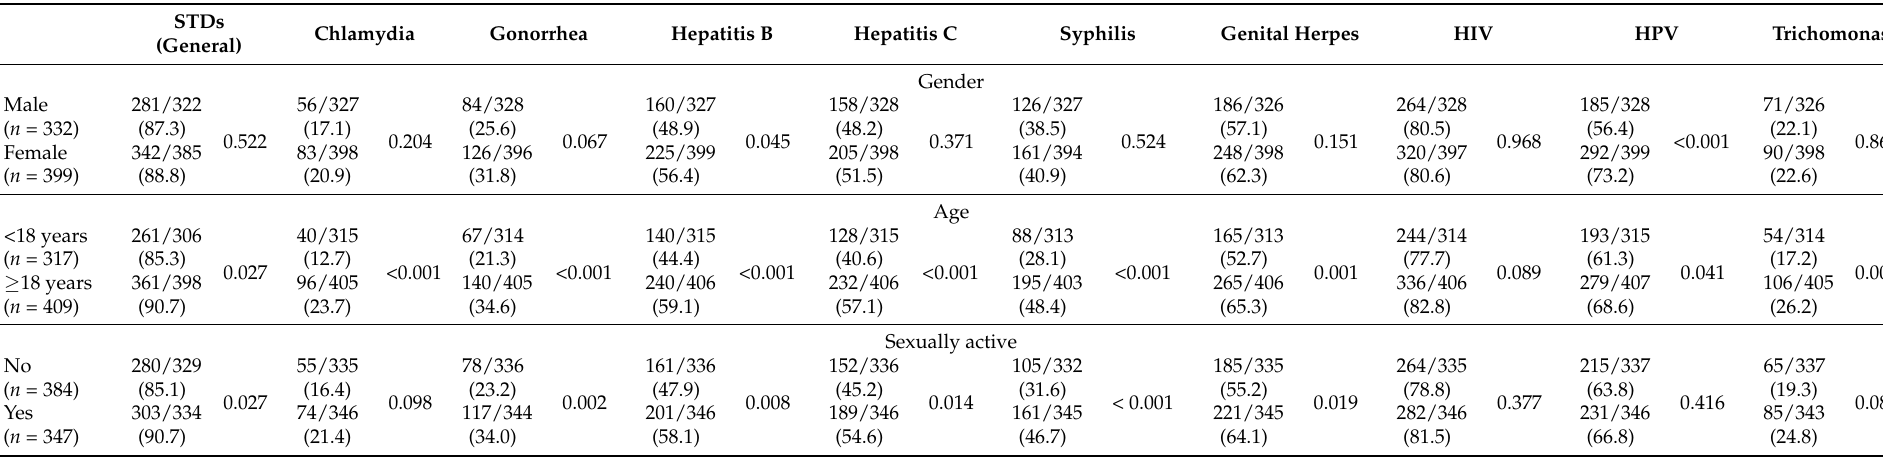
Table 2. Global, and particular knowledge about STDs by gender, age, and sexually active status.